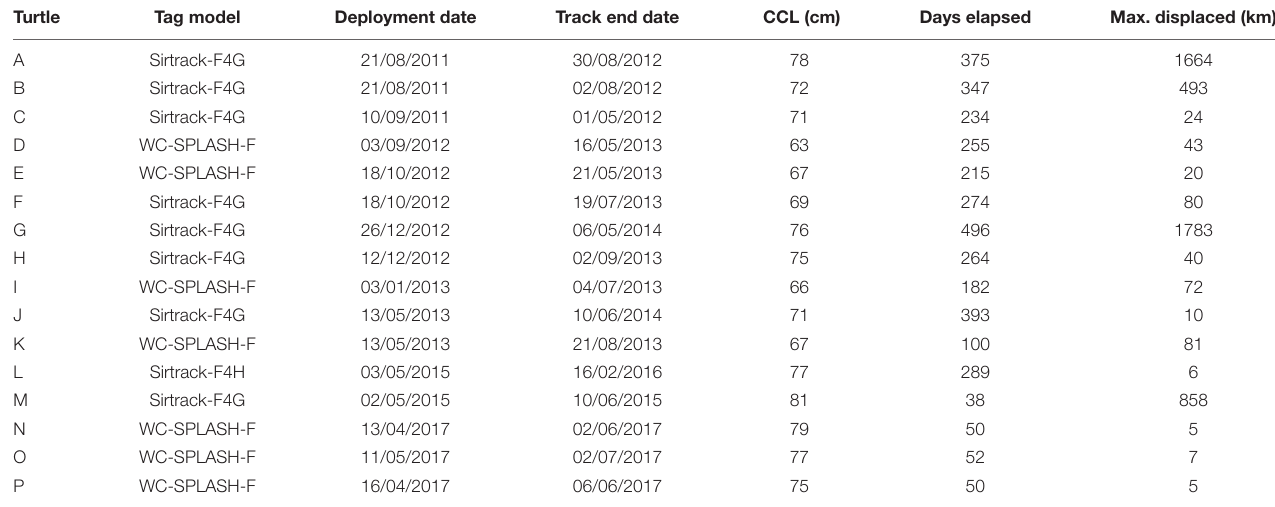
TABLE 1 | Summary table for satellite tracked sub-adult green turtles. Turtle Tag